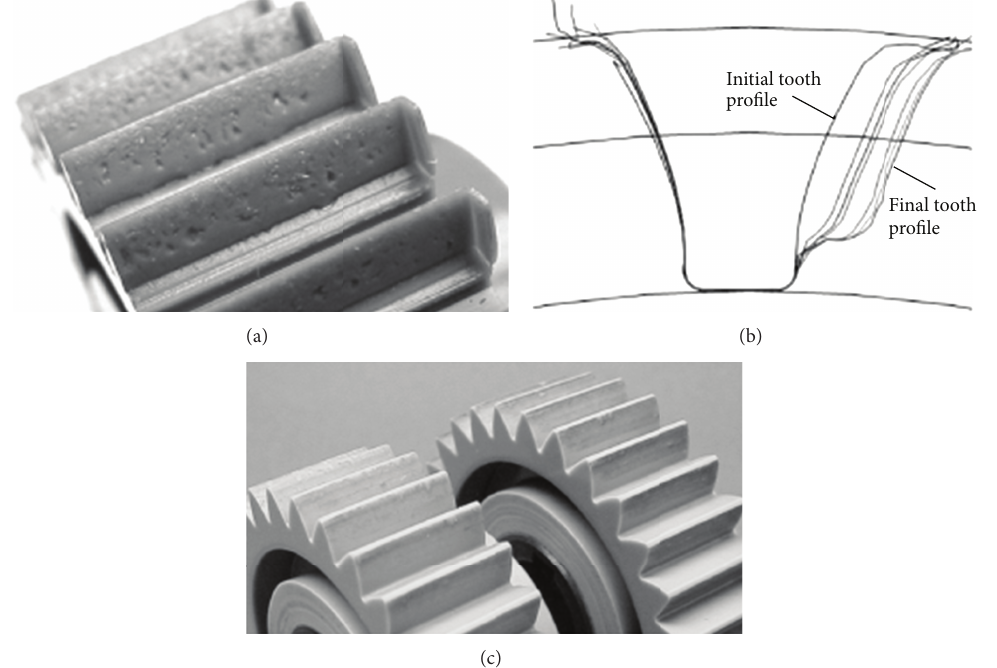
F 11: showing (a) a 20 pressure angle gear ran at 17Nm� (b) the pro�le change over running time for the same gear� and (c) a pair of pressure angle gears run at two different loads (17Nm on the le and 22Nm on the 30 ∘ ∘